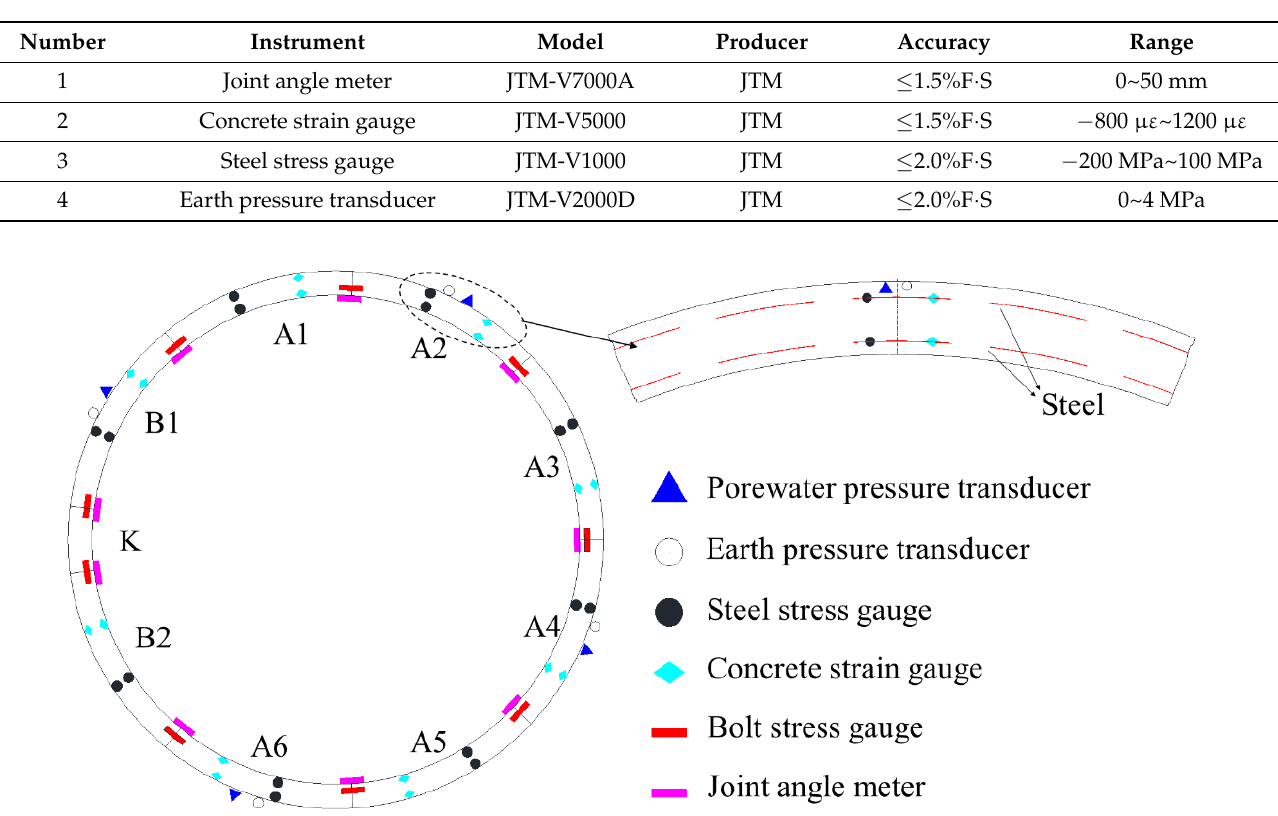
( d ) Figure 8. The on-site installation and layout. ( a ) Diagram of reinforcement gauge installation. ( b ) Installation diagram of the earth pressure box. ( c ) Fiber optic cable box. ( d ) Appearance of part.